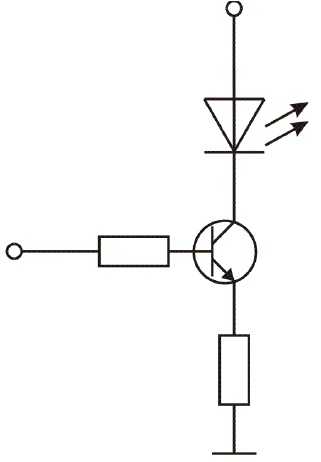
Figure 3. Emitting diode driver circuit [16].